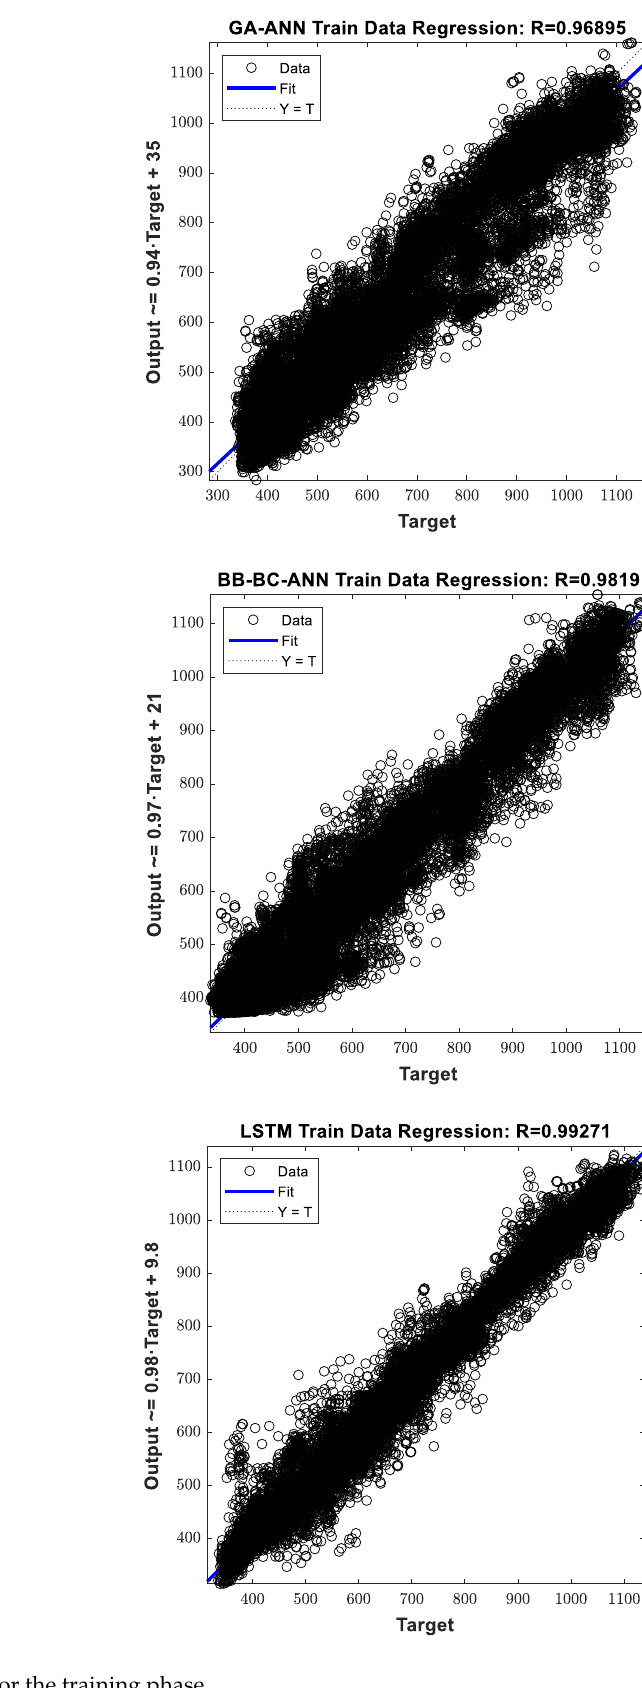
Figure 11. Regression plots for the training phase.